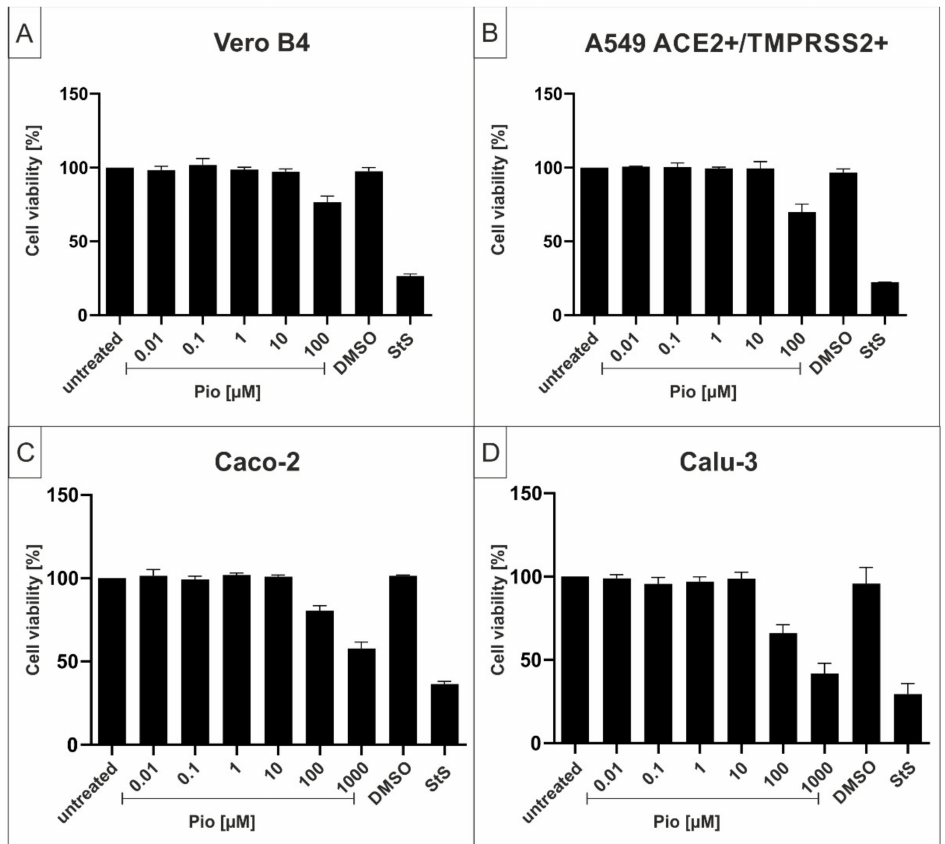
Figure 4. Influence of Pio on the cell viability of Vero B4 ( A ), A549-ACE2+/TMPRSS2+ ( B ), Caco-2 ( C ), and Calu-3 cells ( D ). Following treatment with different concentrations of Pio (Pio concentrations are indicated on the x -axis) for three days, the influence on cell viability was measured by WST-1 assay. Bars represent means of three independent experiments ± SD. StS (1 µ M) was used as a positive control. DMSO as a solvent control, was tested at the same concentration as used in the highest concentration of Pio (100 µ M ( A , B ); 1000 µ M ( C , D